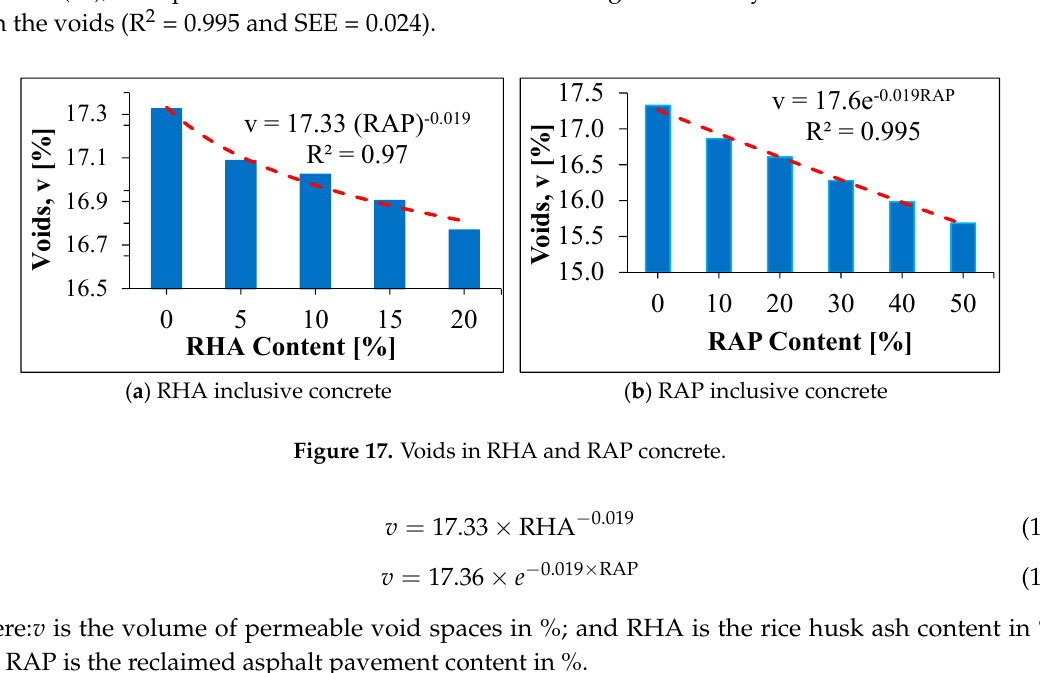
Figure 17 . Voids in RHA and RAP concrete. Figure 17. Voids in RHA and RAP